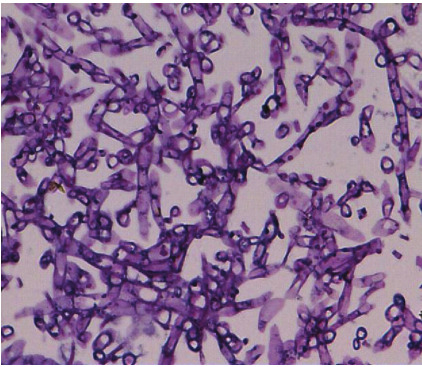
Figure 1: Periodic Acid Schi ff (PAS) stain shows septate, fungal hy- phae (Magnification 40x).